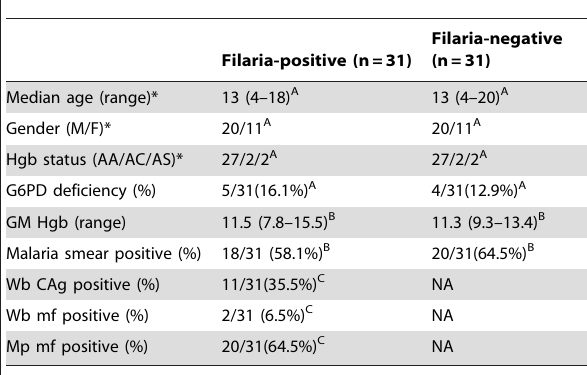
Table 1. Baseline characteristics of the study